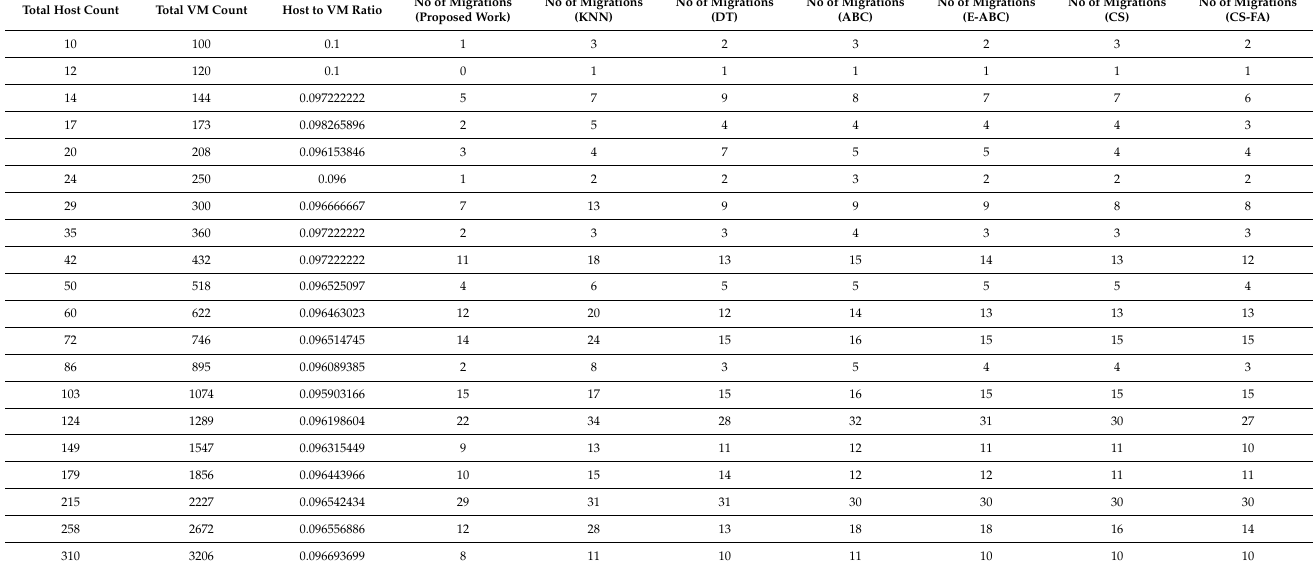
Table 2. Comparison in terms of number of migrations.